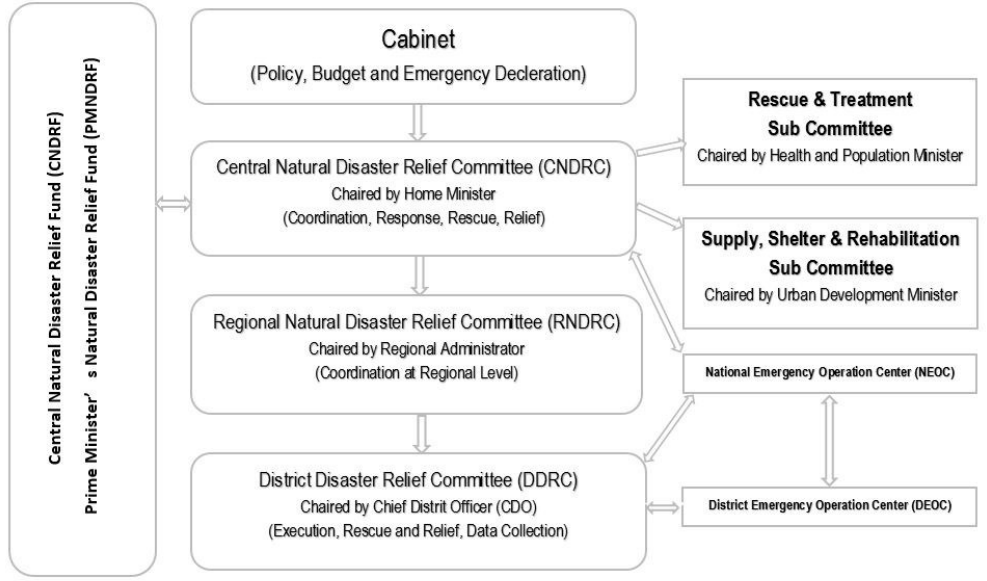
Figure 2. Government institutional arrangement for disaster management. Source: Adopted from Koirala (2014); Ghimire (2015).